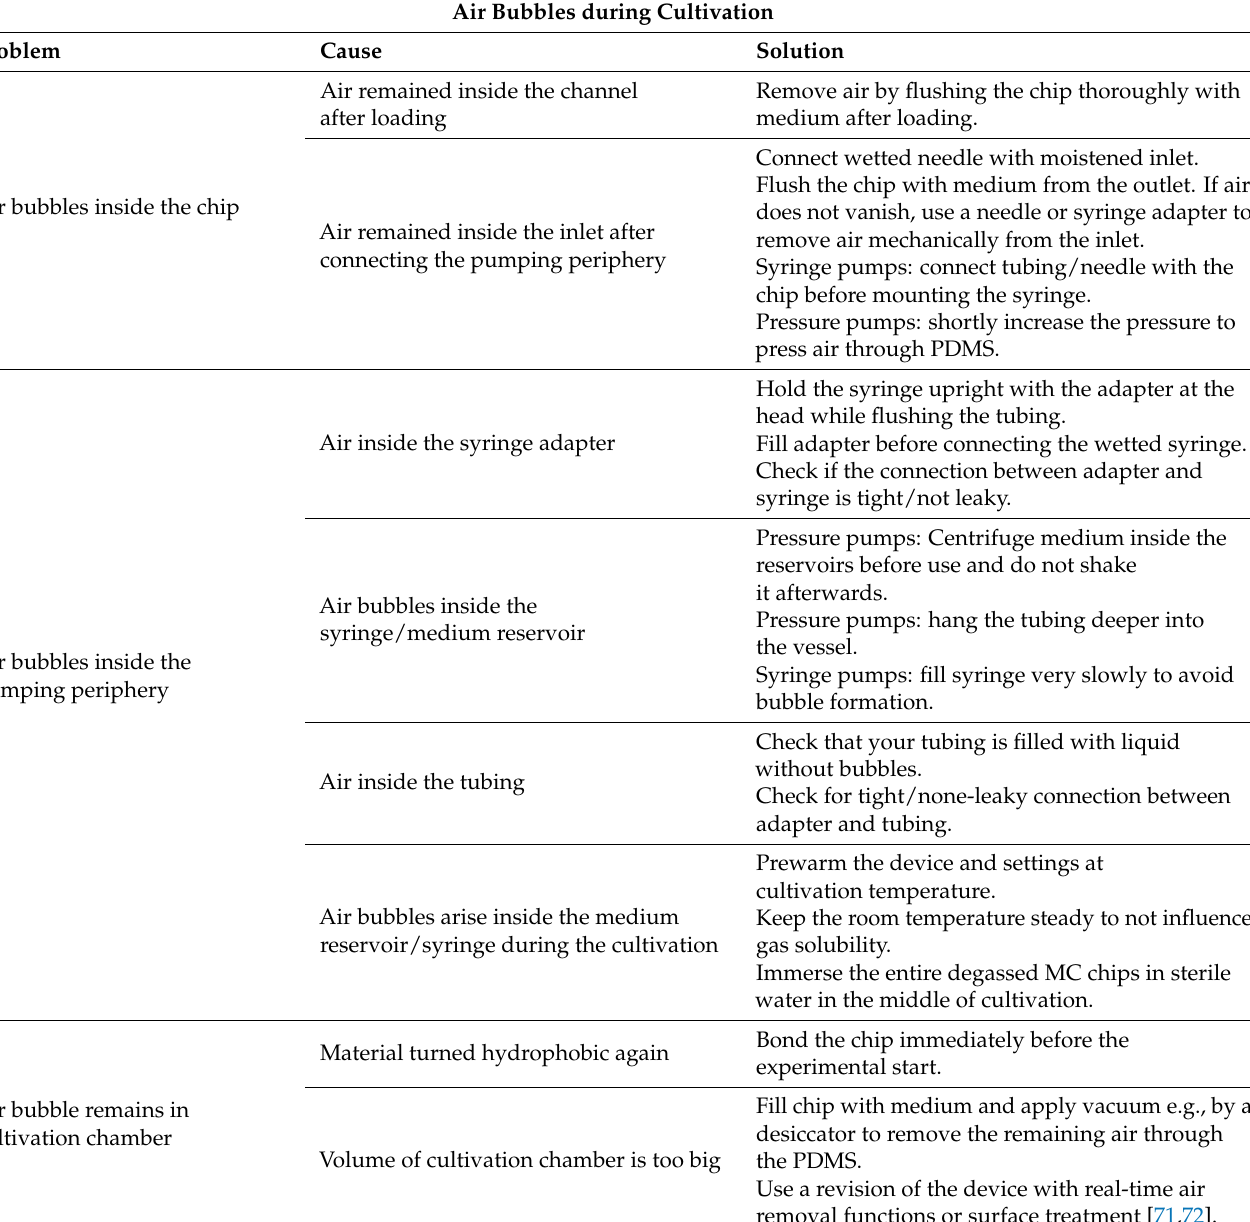
Table 5. Listed are the most frequently occurring challenges concerning air bubbles during cultivation with their respective cause and a suggested